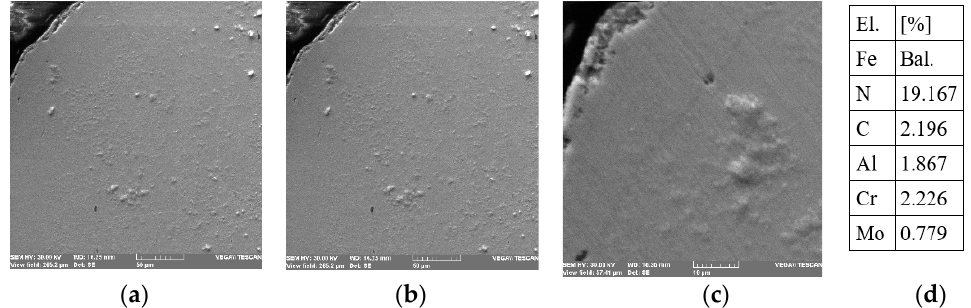
Figure 5. No screen nitrided sample SEM micrographs, 90° area A, different scale: ( a ) 50 µm, ( b ) 20 µm, ( c ) 10 µm, and ( d ) mass concentration of elements per area.